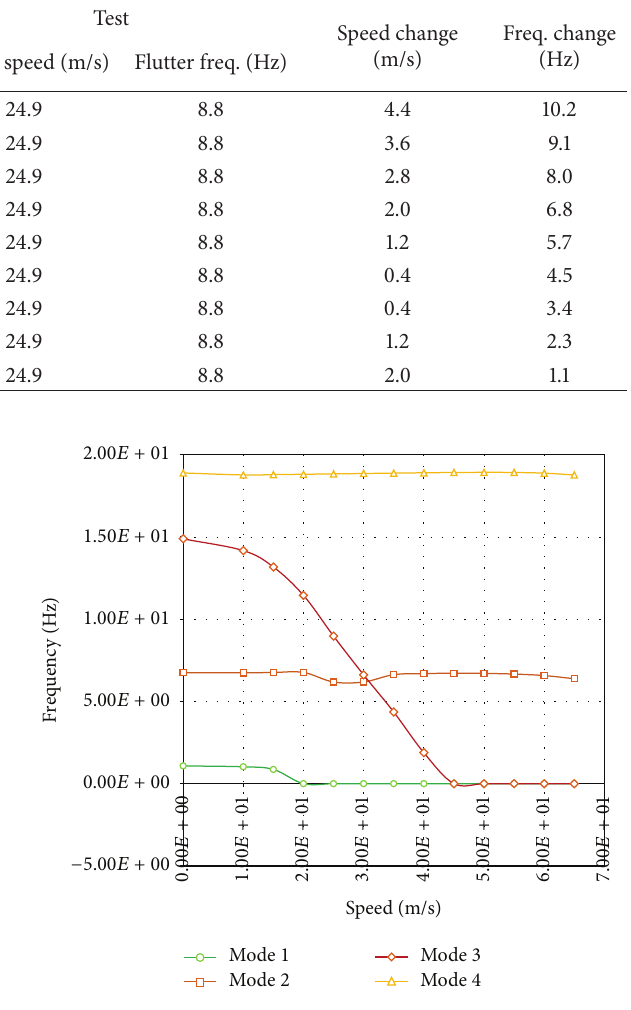
Figure 8: 𝑉 - 𝑓 plot of the rectangular plate.